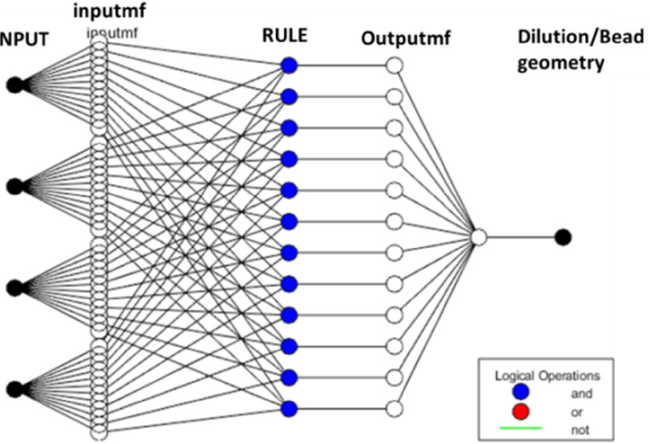
Figure 9. Architecture of developed ANFIS model for predicting the output.